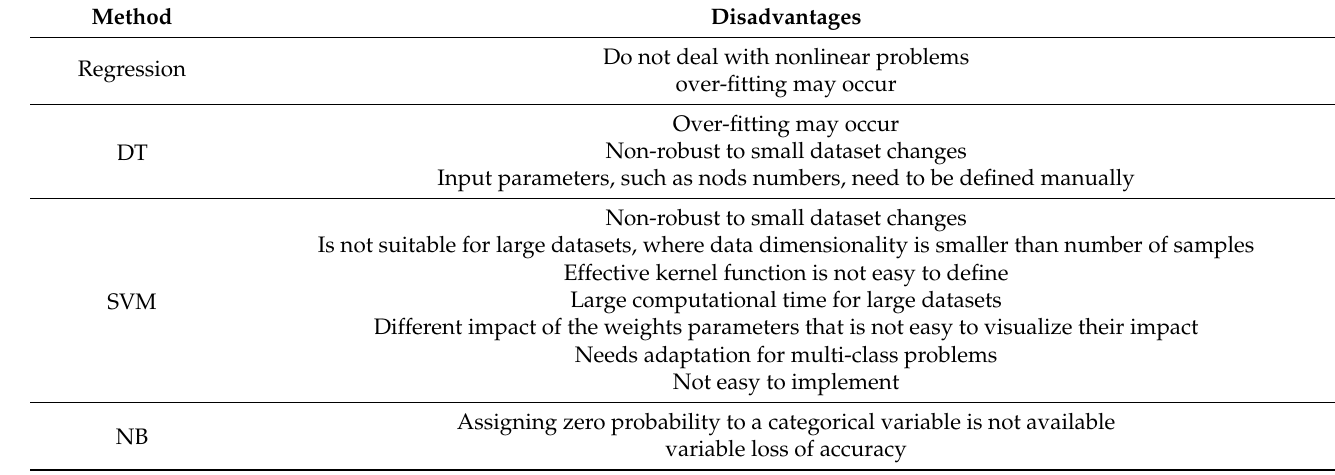
Table 3. Comparison of disadvantages of machine learning